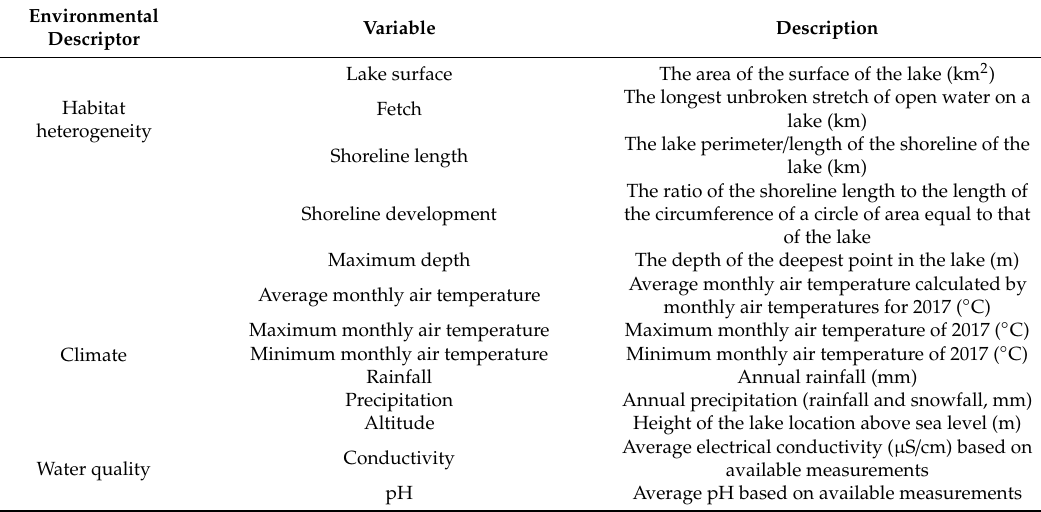
Table 1. The thirteen environmental variables that were included in the analysis, categorized in three groups; habitat heterogeneity, climate and water